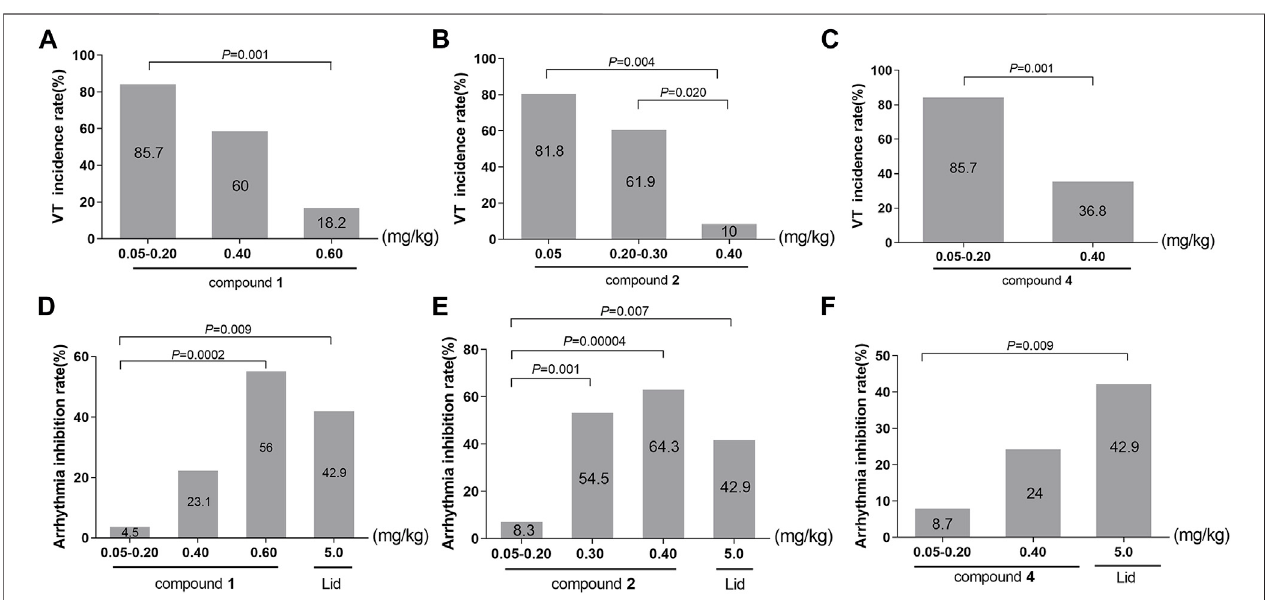
FIGURE 6 | (A – C) Effects of converted products on the incidence of VT. (A) : compound 1 ; (B) : compound 2 ; (C) : compound 3 . (D – F) Effects of converted products on arrhythmia inhibition rate. (D) : compound 1 ; (E) : compound 2 ; (F) : compound 3